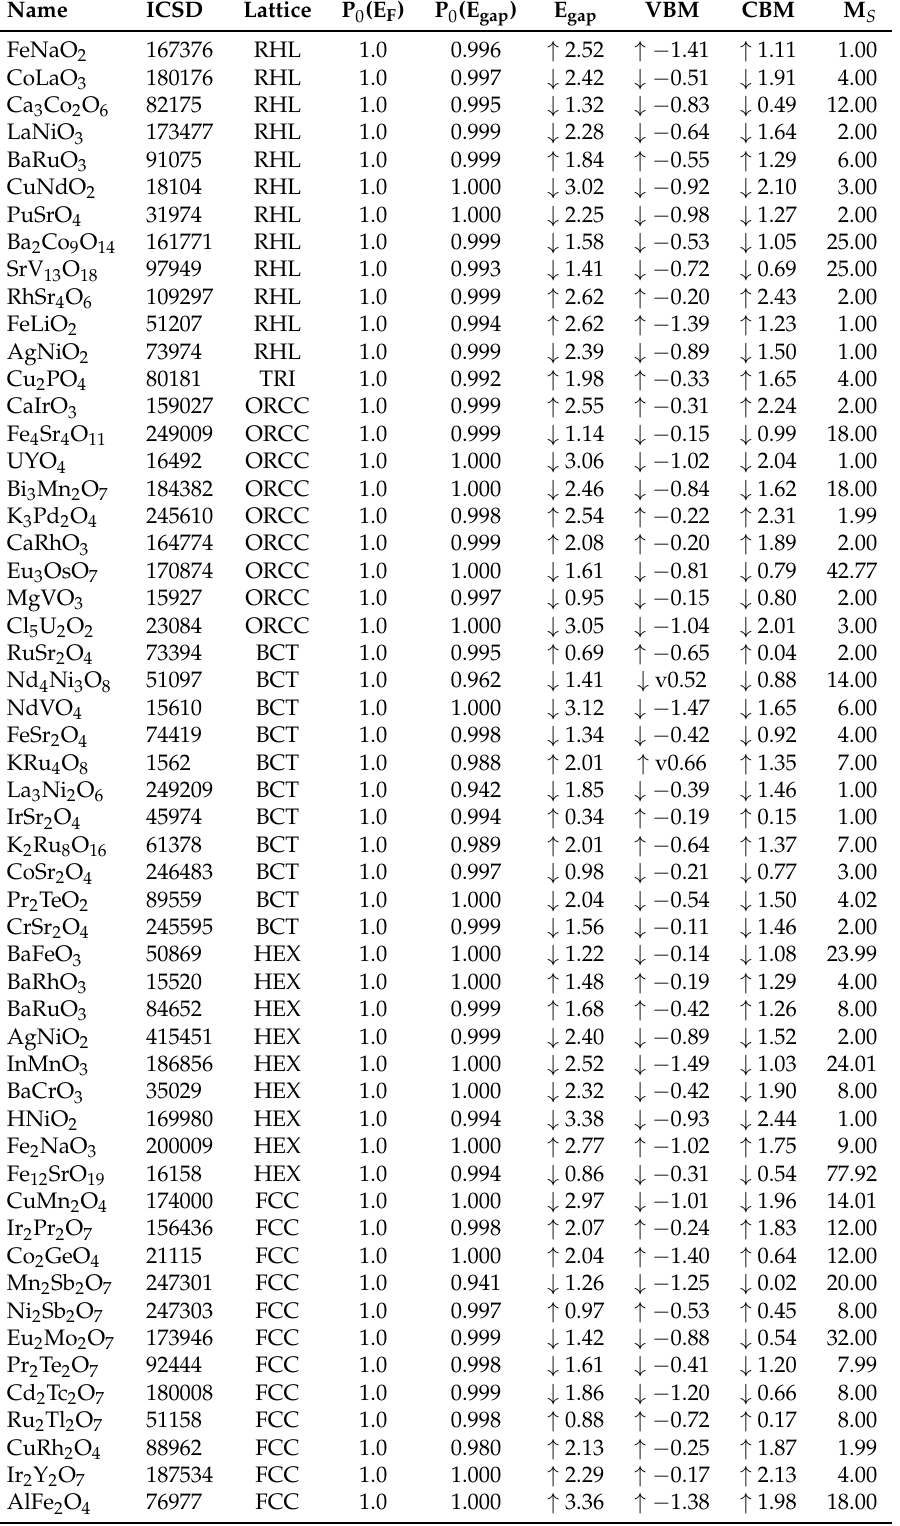
Table A2. Ternary half-metallic oxides. Parameters are the same as in Table